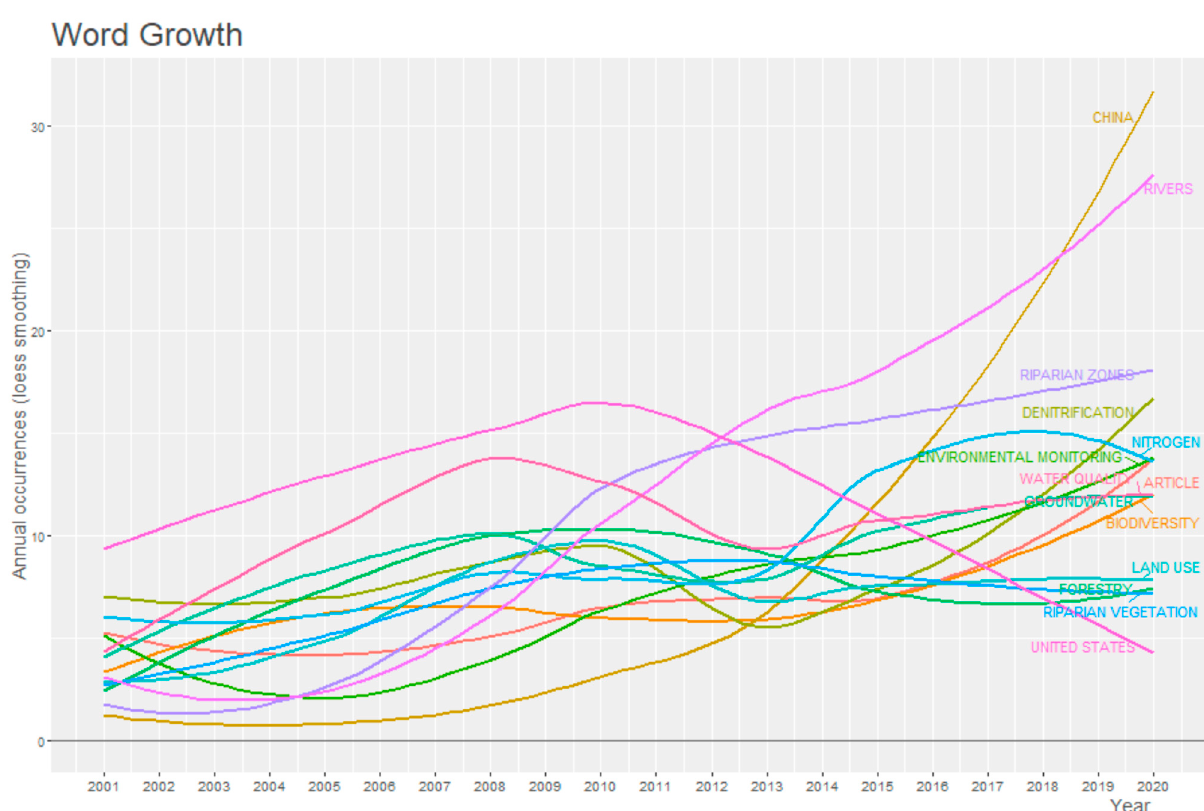
Figure 8. Temporal trend in KeyWords Plus ® associated to riparian zones research (2001–2020).